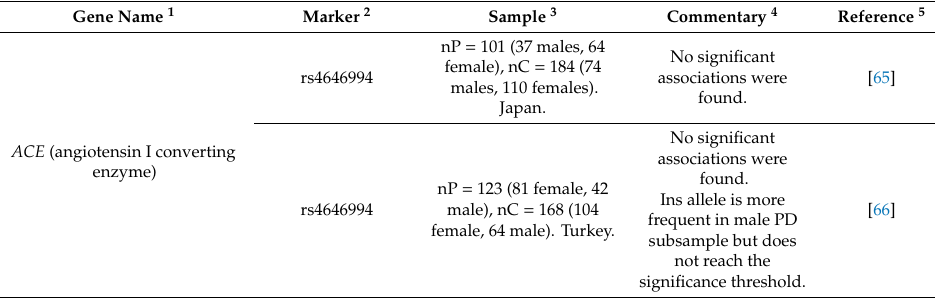
Table 2. Genes with no significant association with PD diagnosis